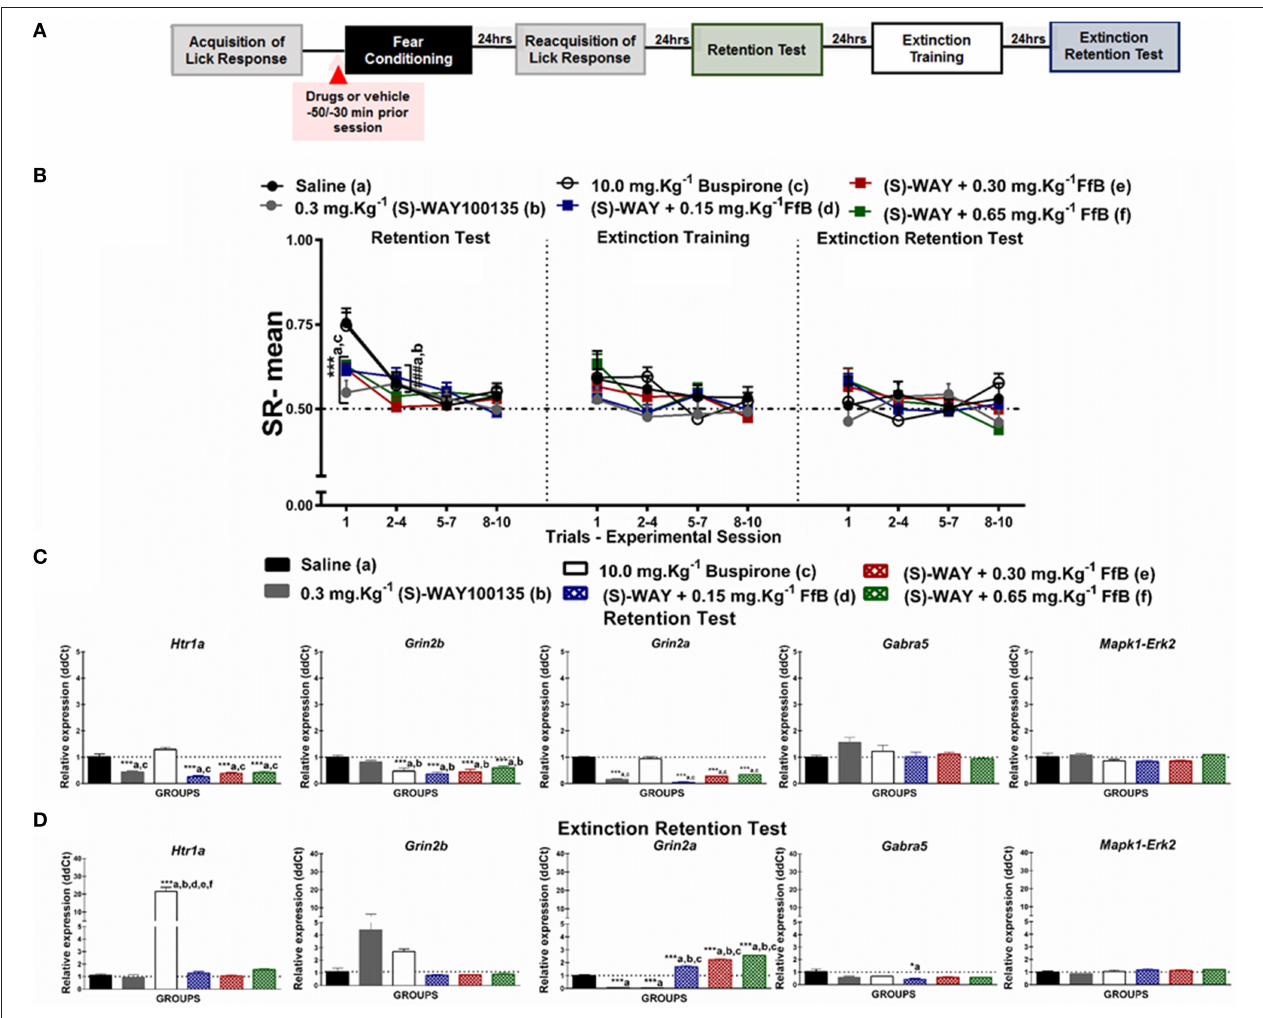
FIGURE 3 | (A) Timeline illustrating the time points of drug administration and brain removal. (B) Mean SR of licking behavior in the test session (8 th day, n = 20 /group), extinction training (9 th day, n = 10 /group) and the extinction retention test (10 th day, n = 10 /group). The first point indicates the mean SR for the